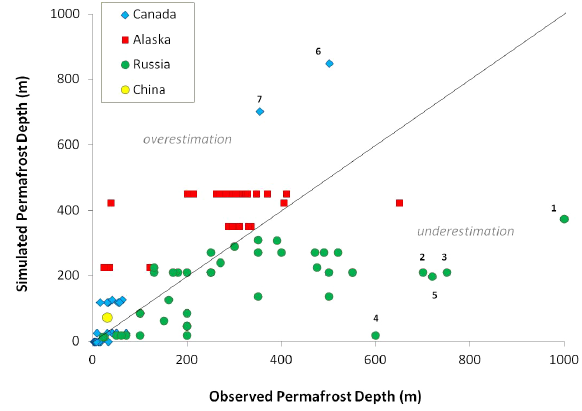
Figure 9. A 1 : 1 scatter plot comparing simulated thickness results with corresponding permafrost thickness estimates from borehole data. Points 1–7 are outliers mentioned specifically above.